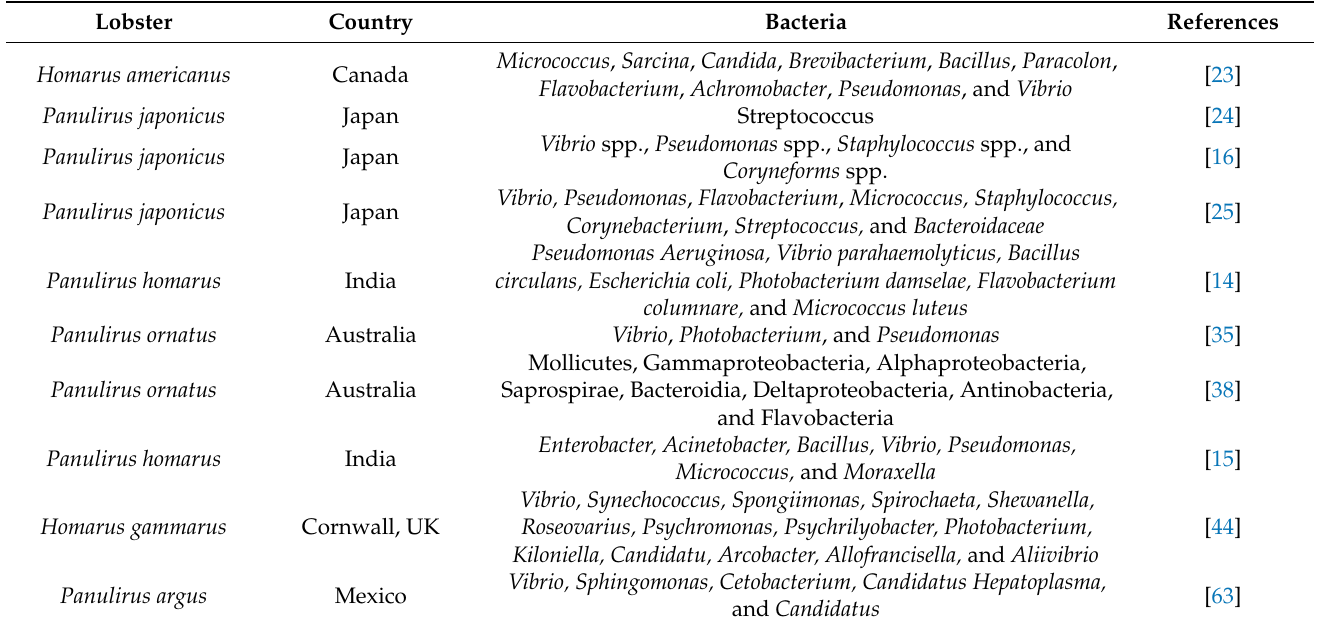
Table 1. Bacteria community in the GI tract of lobsters from year